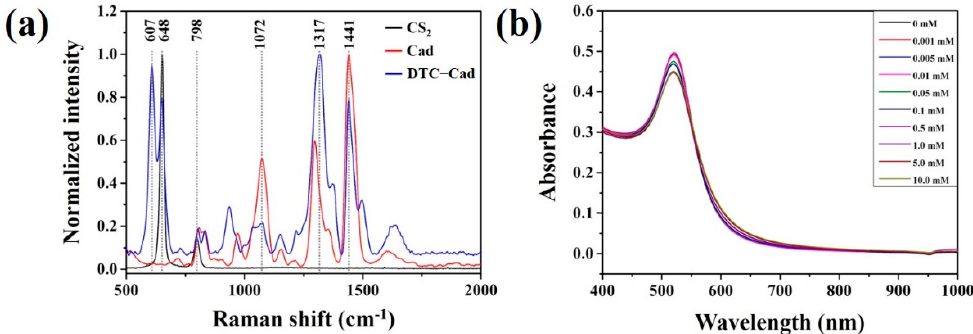
Figure 2. ( a ) Raman spectra of CS 2 , Cad and DTC-Cad, and ( b ) absorption spectra of DTC-Cad with various concentrations of CS 2 .